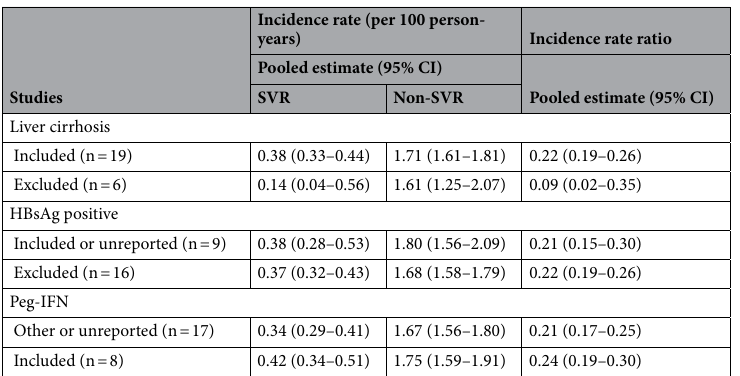
Table 4. Subgroup analyses of pooled estimates of the crude incidence rate (per 100 person-years) and incidence rate ratio of HCC in patients treated with antiviral therapy (SVR vs. non-SVR) related to liver cirrhosis, HBsAg positivity, and Peg-IFN use. HCC hepatocellular carcinoma, SVR sustained virologic response, Peg-IFN pegylated interferon, CI confidence interval.